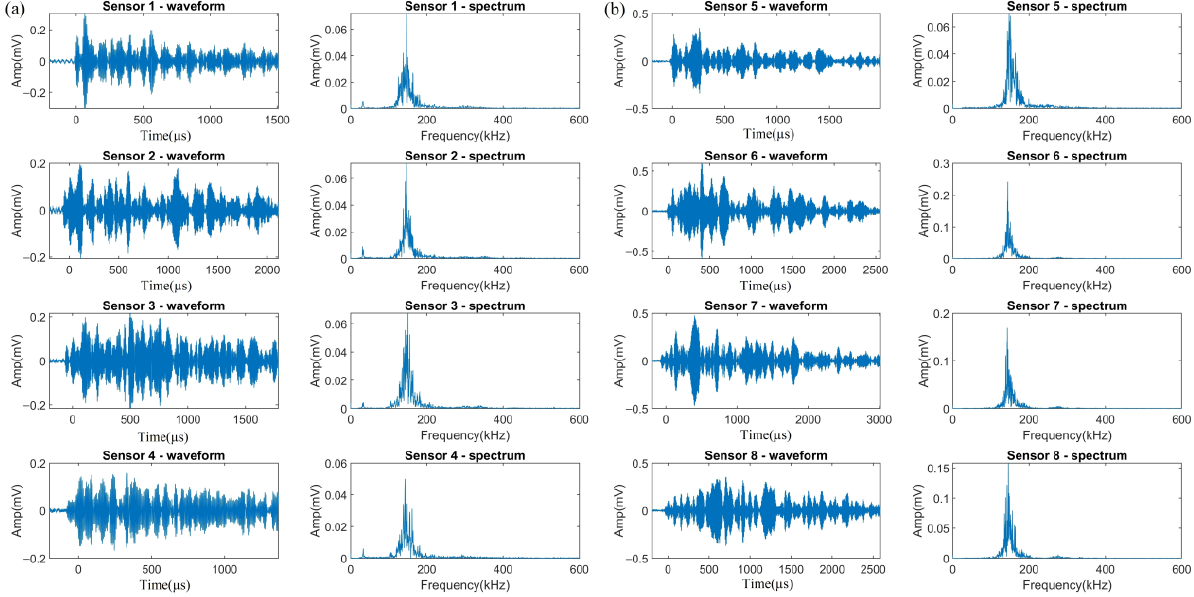
Figure 9. The waveforms and spectrums from the same event of HIC acquired by ( a ) Nano30 sensors and ( b ) VS150-RIC sensors.